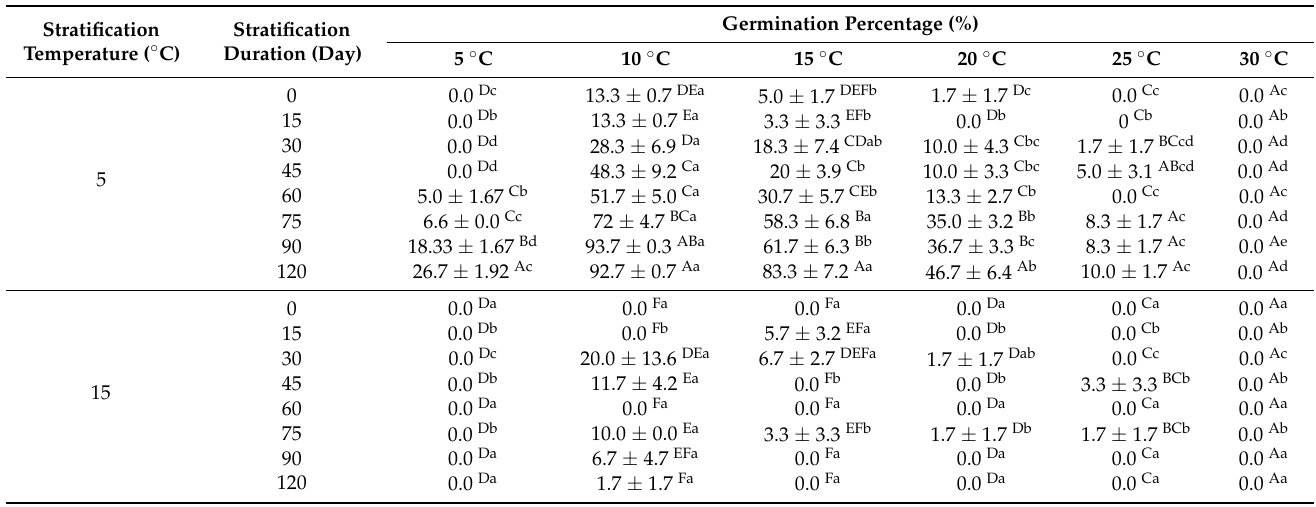
Table 2. Germination after stratification.